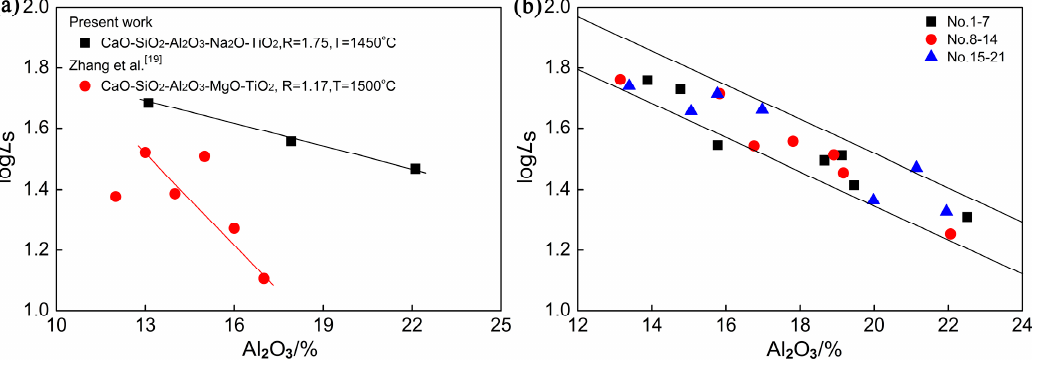
Figure 6. Effect of Al 2 O 3 on log L S .